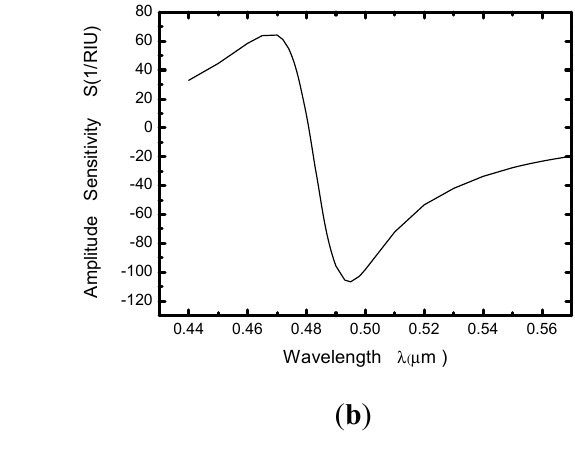
≈ 6nm), respectively; ( b ) Intensity peak